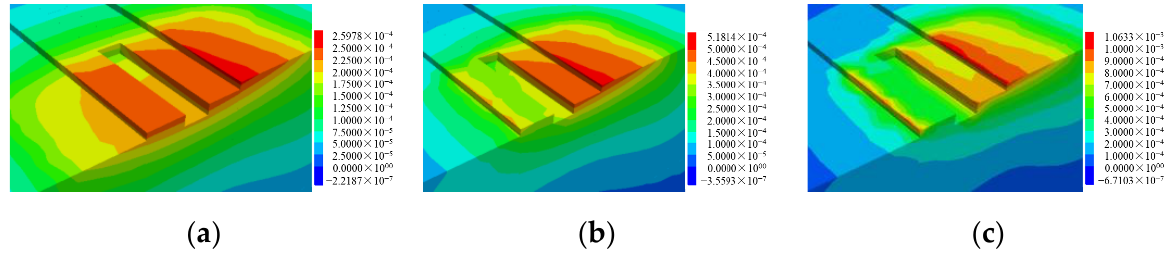
Figure 16. Variation of the displacement of the foundation rock mass with the increasing lateral thrust. (Unit in m). ( a ) 2 × design load (500 kN); ( b ) 3 × design load (750 kN); ( c ) 4 × design load (1000 kN).